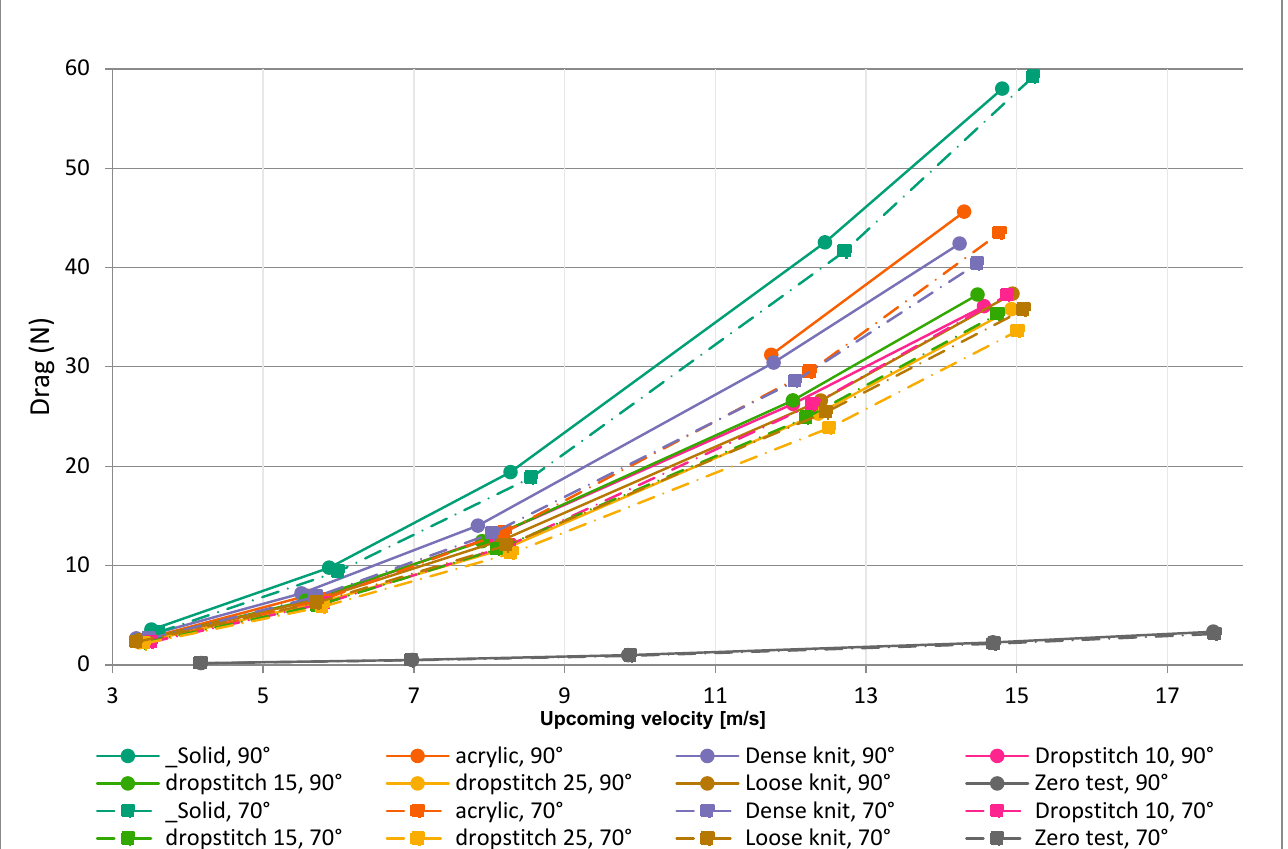
Figure 16. Free-body diagram of the frame for the tested models.